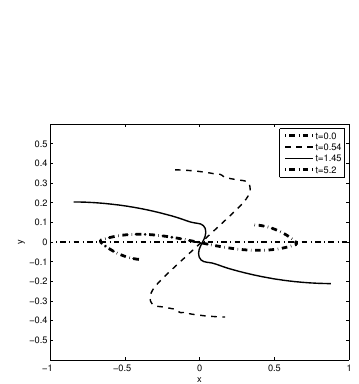
Figure 17. Droplet dynamics with the Lattes and Lions regularization at ωτ = 0 ⇒ 8, (cid:15) = 4 × 10 − 4 .